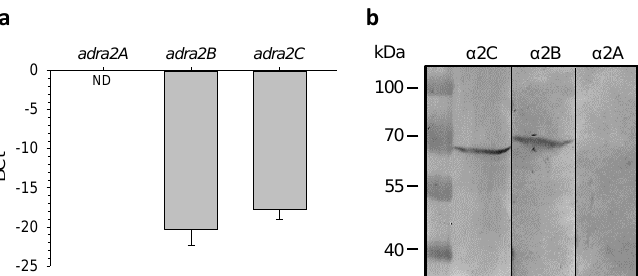
Figure 5. The mRNA and protein expression levels of the α 2-AR isoforms in the mouse left ventricle. ( a ) mRNA expression of the α 2 adrenoceptor genes obtained using the RT-qPCR assay. In contrast to adra2B and adrs2C genes the expression of adra2A was not detected (ND). ( b ) Western blots confirmed the expression of α 2B and α 2C but not α 2A receptor proteins in the mouse left ventricular tissue.